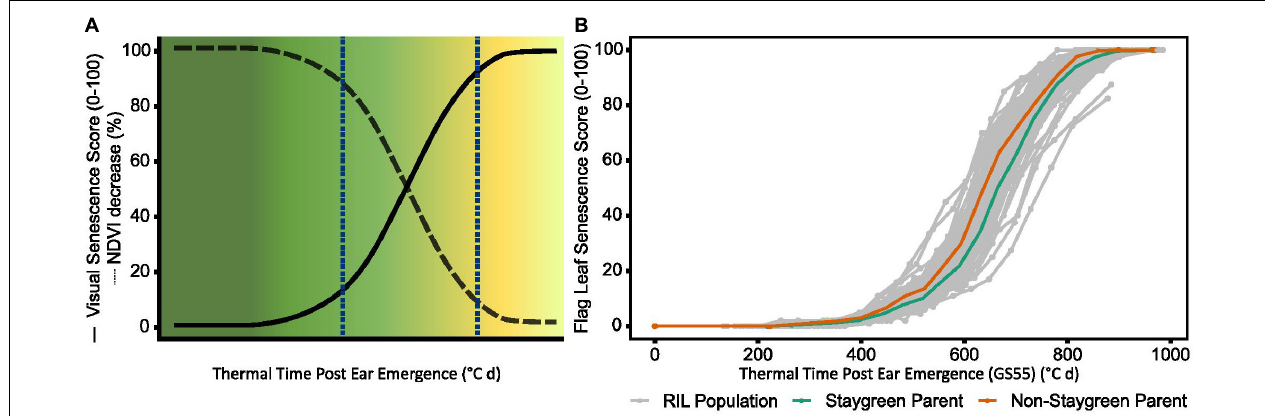
FIGURE 1 | During the rapid senescence phase flag leaves transition from green to yellow (A) , with inter-line variation sometimes difficult to distinguish (B) . Senescence is scored on a 0–100 scale based in progression of leaf yellowing (visual) or greenness reduction (NDVI-based). Scores are plotted against thermal time post-anthesis ( ◦ C day) to standardize for heading date variation. (B) Senescence variation recorded for a segregating RIL population (gray, n = 75), staygreen parent (green), non-staygreen parent (orange) (B) ; mean visual senescence score ( n ≥ 2), Church Farm, Bawburgh, Norwich,